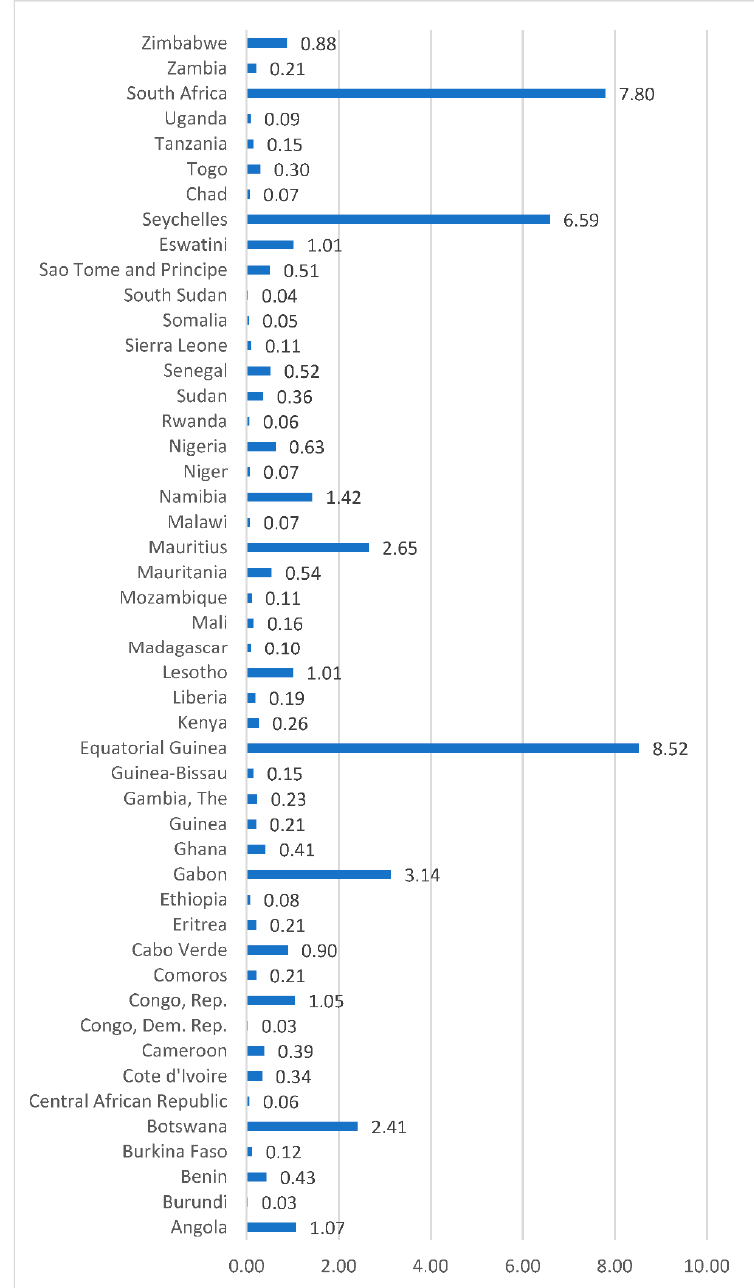
Figure 1. CO 2 emissions per person in Sub-Saharan Africa, 2000–2015. Table 1. Summary statistics.